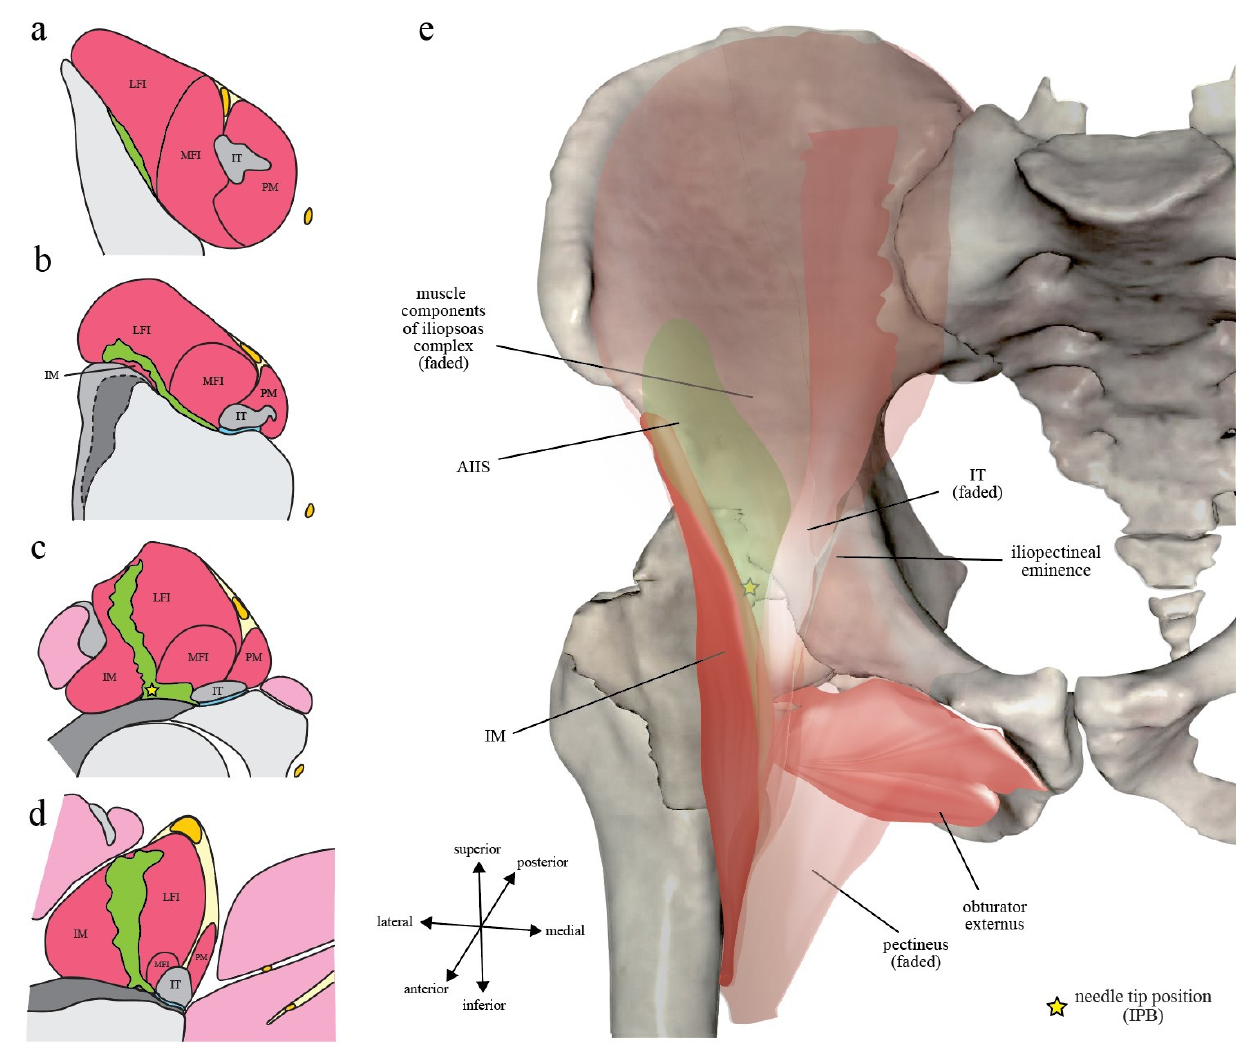
Figure 6. Injectate spread in living human subjects after iliopsoas plane block (IPB): ( a – d ) The most commonly observed pattern of injectate spread after 5 mL IPB, illustrated as the green-colored area, is superimposed on the four transverse section levels as depicted in Figure 1; ( e ) The injectate spread is colored in faded green and is overlayed by the iliopsoas complex to demonstrate its spatial relationship to iliacus minor (IM) and iliopsoas tendon (IT). Note that the injectate is confined within a well-defined iliopsoas plane (IP) without the extra-IP spread that is deep and medial to IT as in PENG block (Figure 5). However, there is superficial spread via the muscular IP towards fascia iliaca compartment (FIC) (c,d), potentially reaching femoral nerve proper when given higher volume of injection. The illustrated Figure was made from an image acquired from the VH Dis-sector with permission from Touch of Life Technologies Inc (www.toltech.net, accessed on 20 July 2022), based on the magnetic resonance images by Nielsen et al. [7]. The original image was reconstructed from real cadavers by the Visible Human Project® of National Library of Medicine.